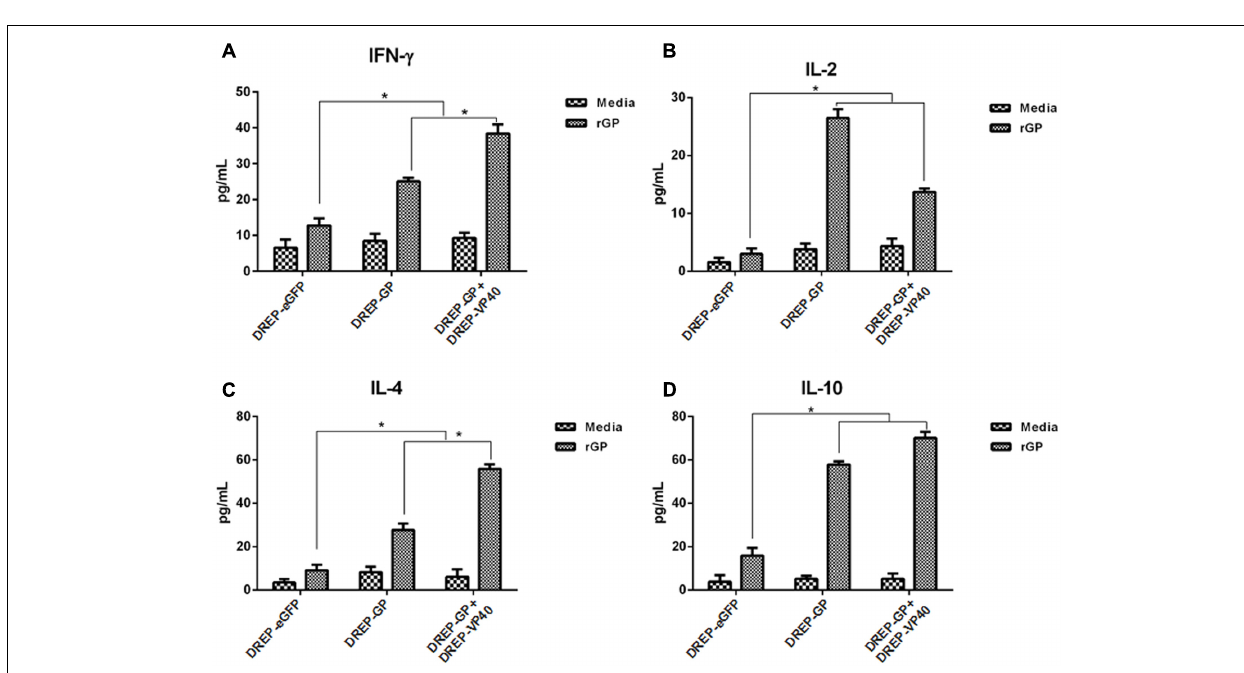
FIGURE 4 | ELISA analysis of cytokines secreted by splenocytes from immunized mice upon stimulation with EBOV recombinant GP proteins (rGP). (A–D) Determination of the cytokines IFN- γ (A) , IL-2 (B) , IL-4 (C) , and IL-10 (D) production in the supernatant of splenocytes by ELISA 2 weeks after the final immunization. The results for three independent experiments are shown as the mean ± SD. ∗ p < 0.05.